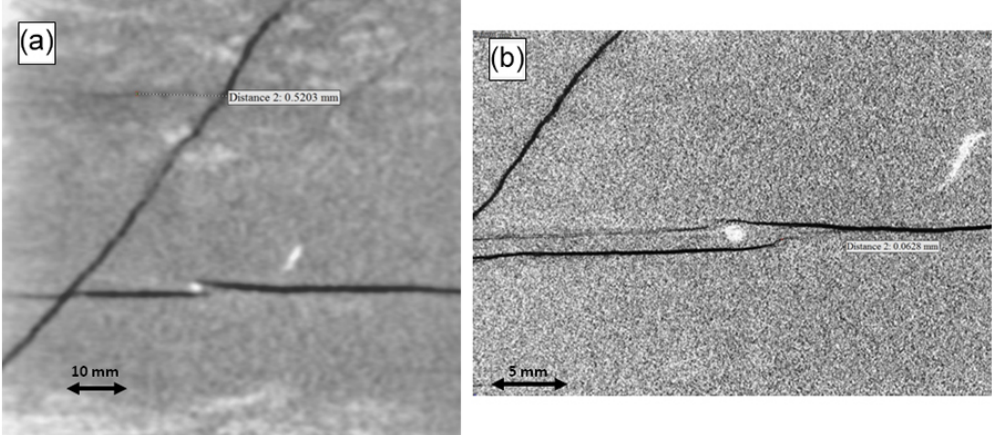
Figure 10. Direct comparison of both coarse-resolution scans with different techniques. Either enhanced phase contrast or spatial resolution can be derived. Hence, both techniques should be used